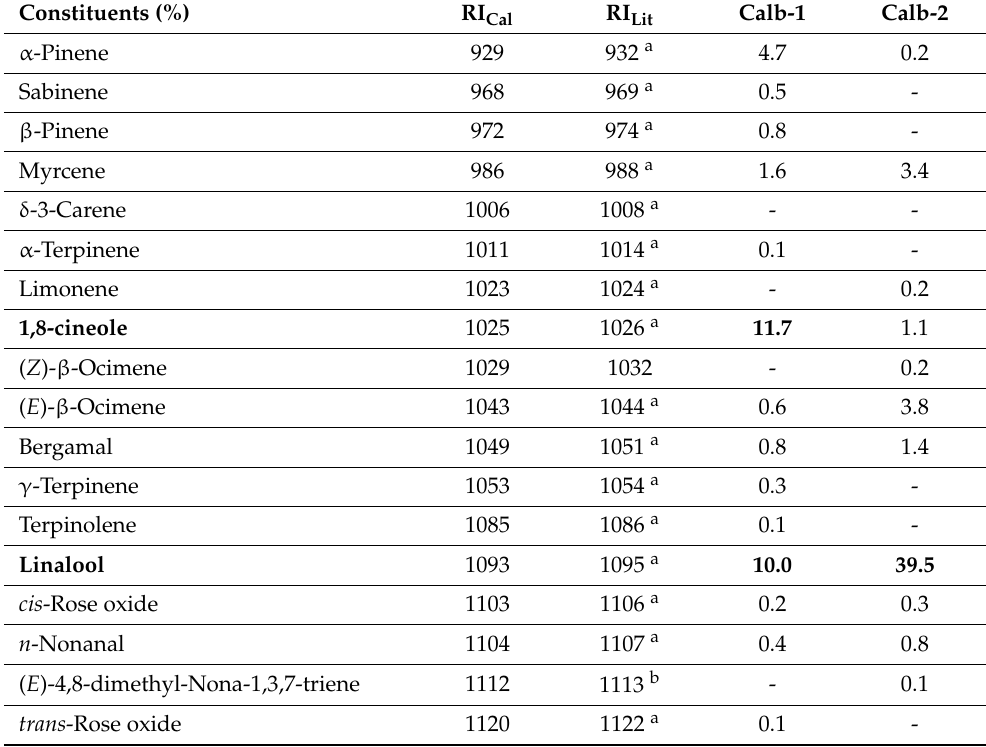
Table 2. Constituents identified in the volatile concentrates of two specimens of C. albovirens